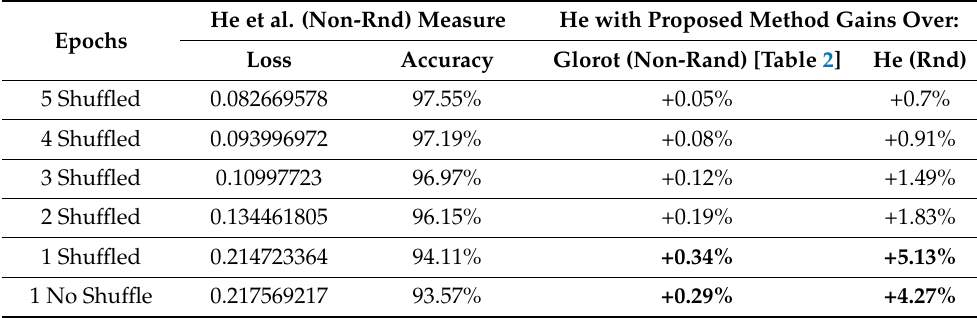
Table 3. He et al. limits with the proposed initialization method and gains in